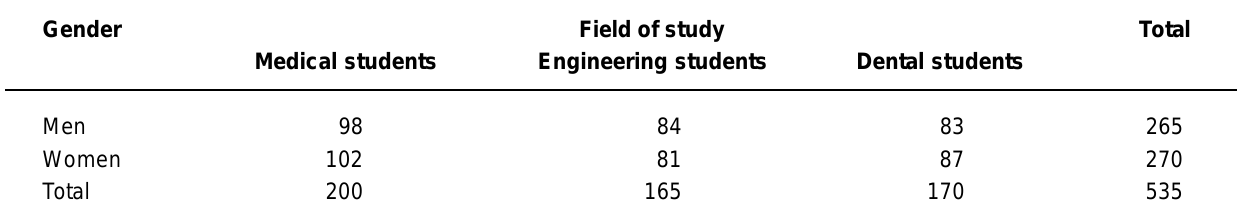
TABLE 1- The distribution of the subjects based on gender and the study